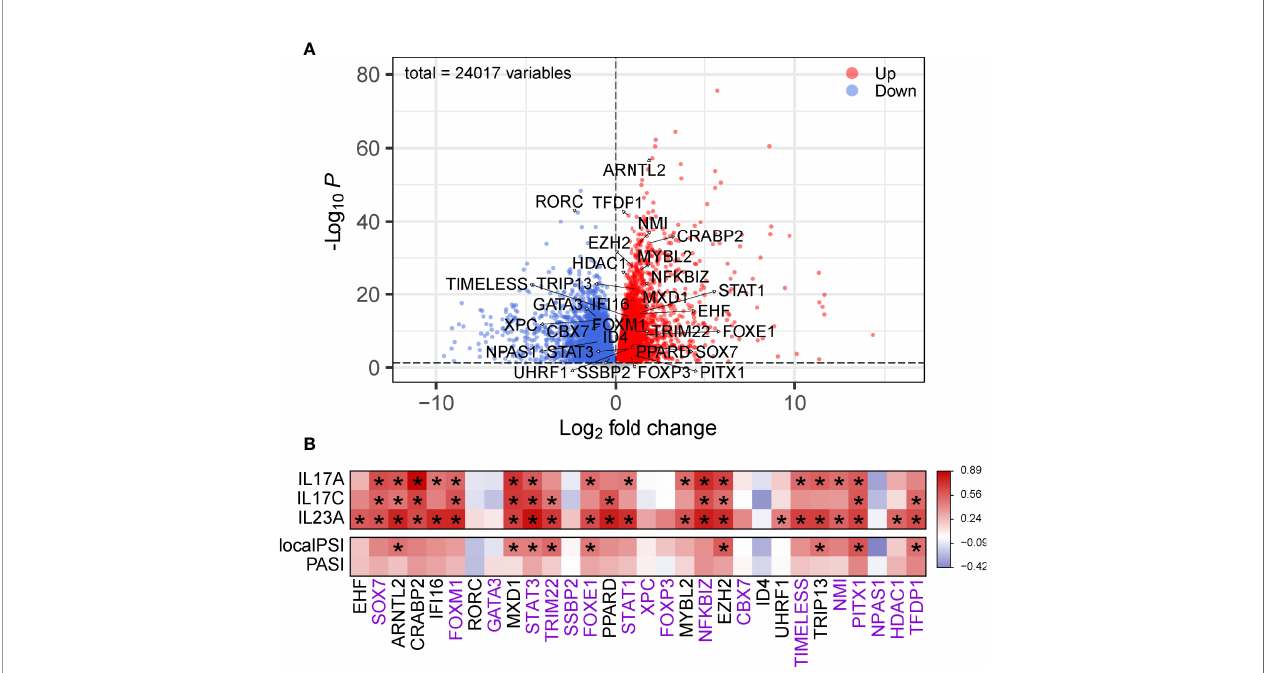
FIGURE 4 | Validation of the identi fi ed regulators. (A) Volcano plot of DEGs in psoriatic lesional compared to non-lesional skin. The top 30 regulators are labeled with their names. The red dots are the genes with both a false discovery rate (FDR) smaller than 0.05 and a log2FoldChange greater than 0. The blue dots are the genes with either an FDR smaller than 0.05 or a log2FoldChange smaller than 0. (B) Heatmap of correlation between the top 30 regulators and gene markers or measures of disease severity. Color denotes r value of correlation. The gene names with purple are considered as unique DEGs of psoriasis, with black are shared genes with AD. * Adjusted P <